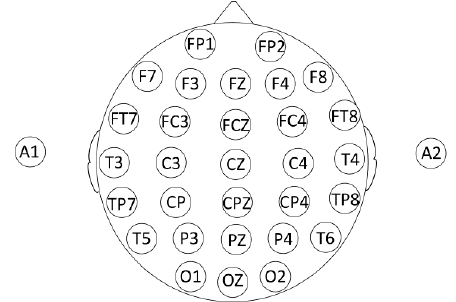
Figure 1. Channel location .